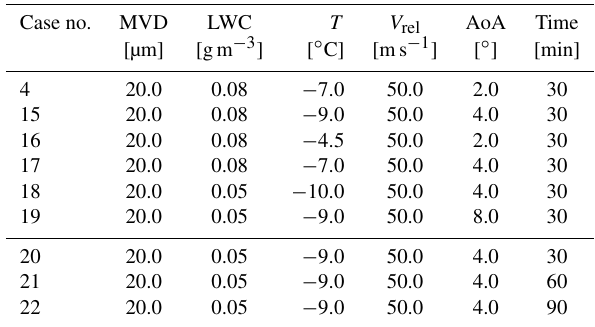
Table 4. Test conditions of AERTS test